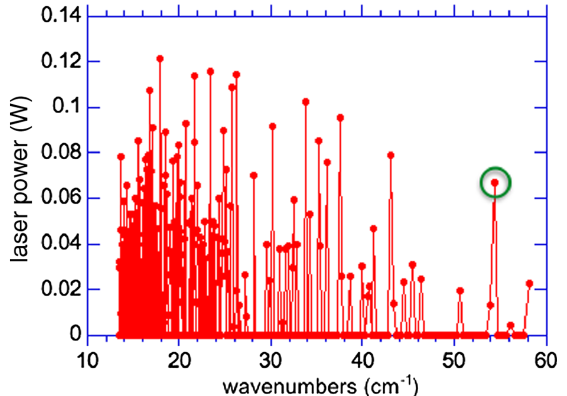
FIG. 4. Numerical simulation of the output laser power of FLARE.